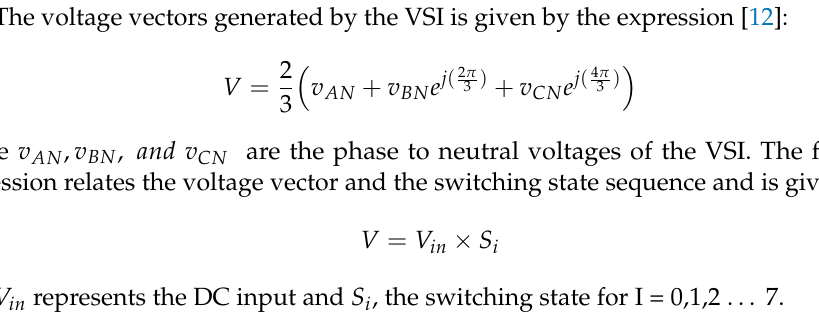
Figure 1. Circuit diagram of a two-level three-phase